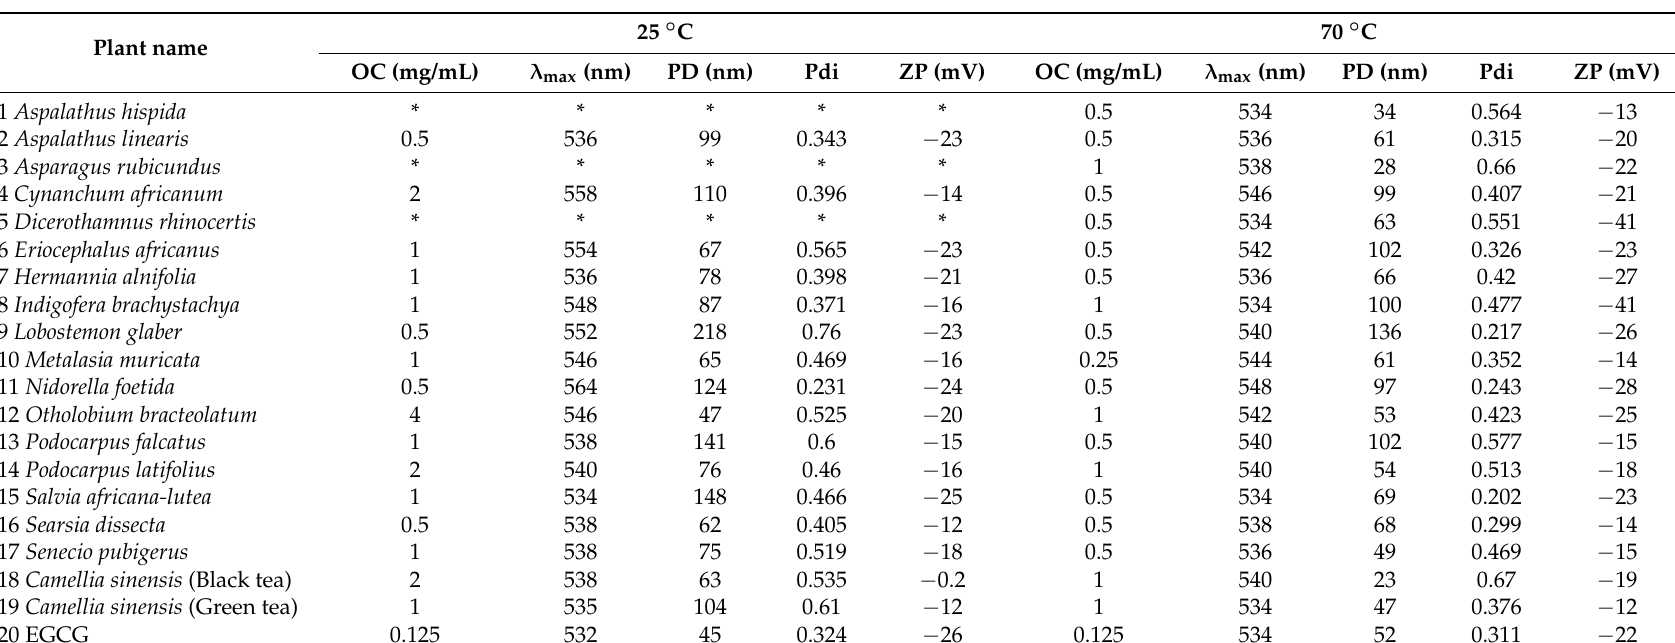
Table 1. The optimum concentration (OC), particle diameter (PD), the polydispersity index (Pdi), λ max and average zeta potential values (ZP) of the AuNPs synthesized from the plant extracts at 25 ◦ C and 70 ◦